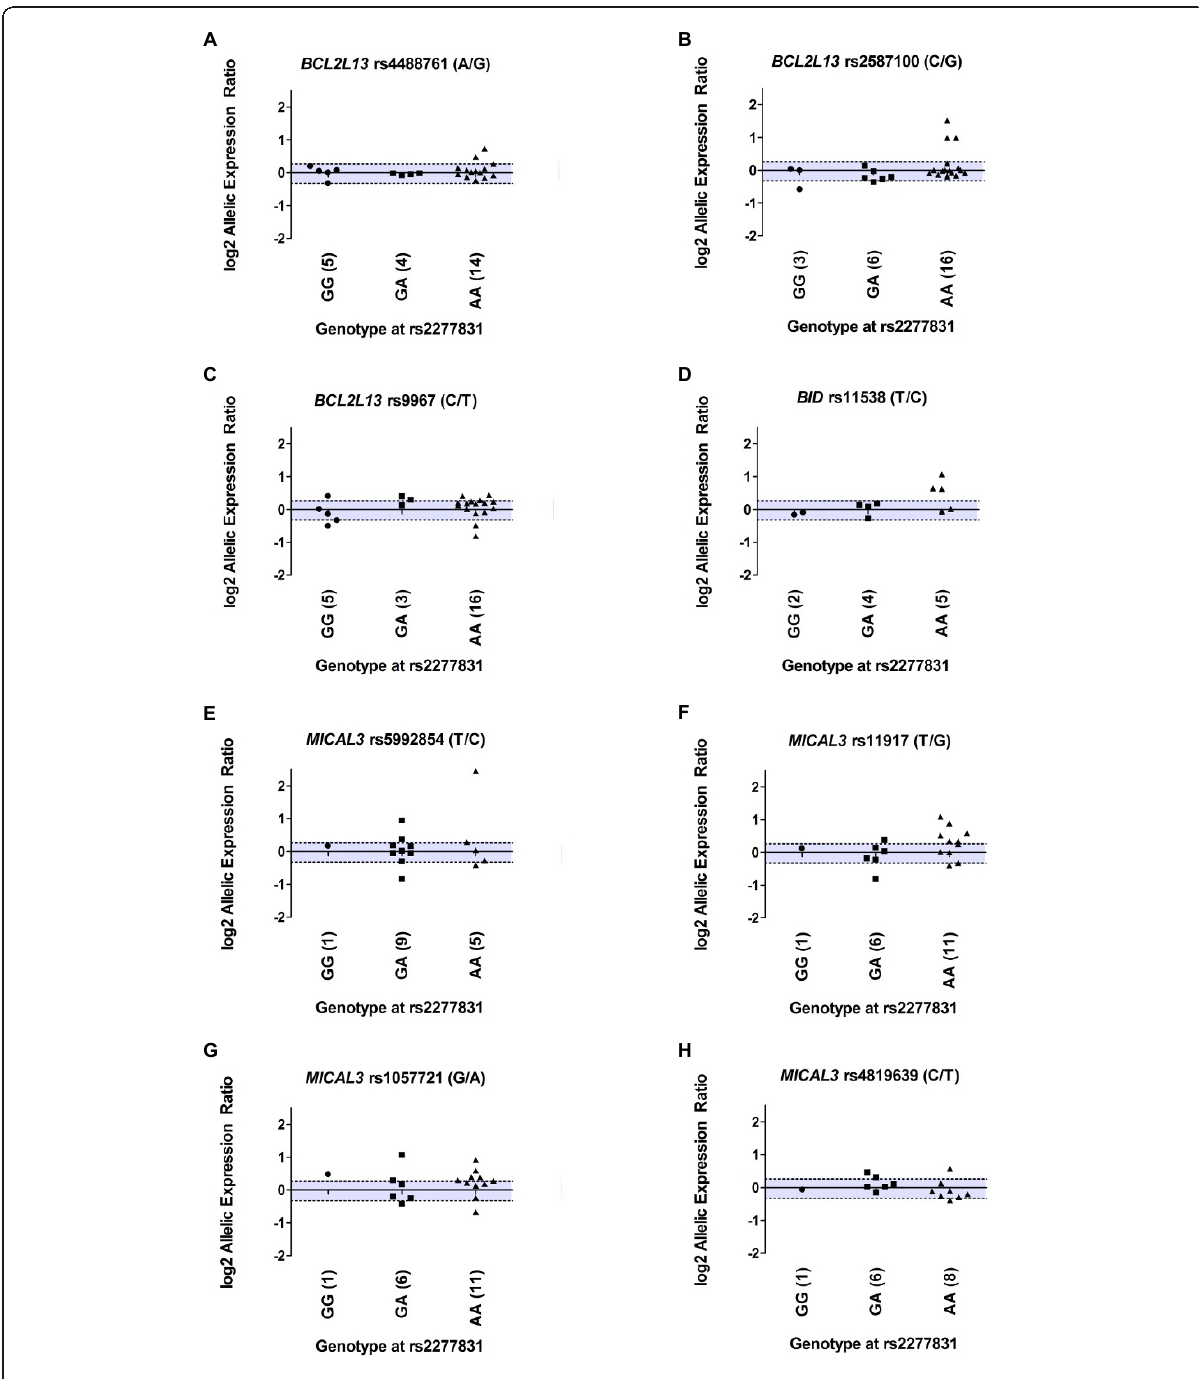
Figure 4 Allelic expression imbalance in patients at the eight transcript SNPs studied